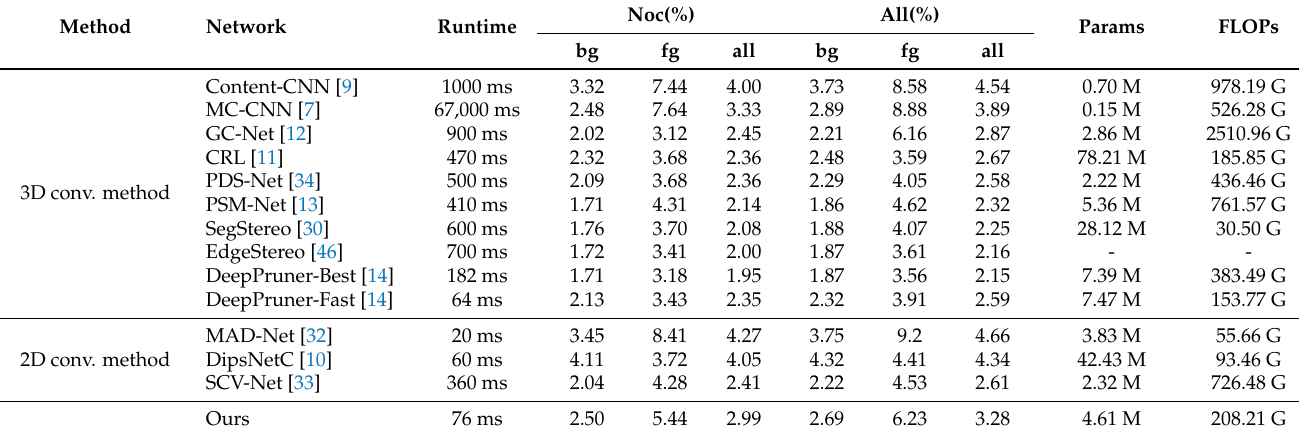
Table 4. Evaluation results on the KITTI 2015 test